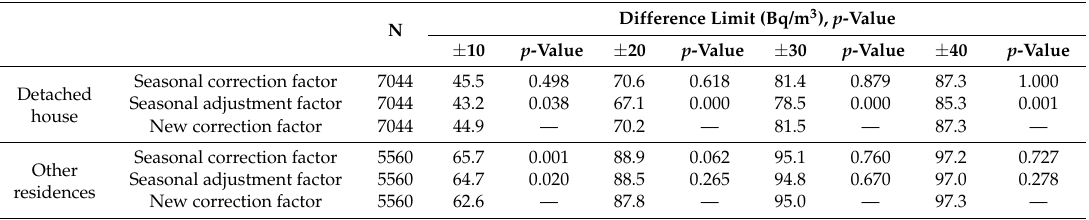
Table 6. Percentage of estimated mean annual radon concentrations within specific difference limits according to types of houses and correction factors.